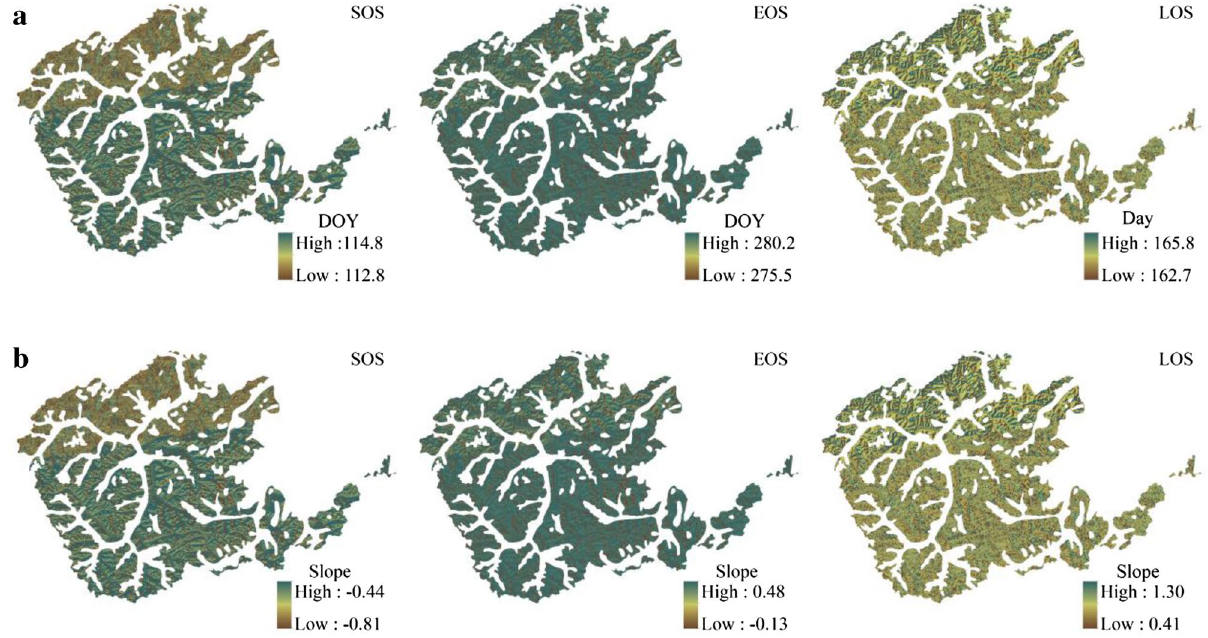
Figure 4. Variation trend of RSP in the Greater Khingan Mountains from 2000 to 2020 ( a mean value; b